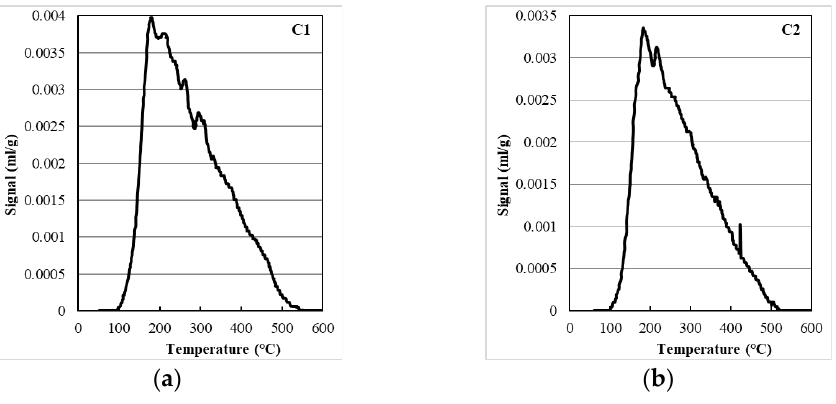
Figure 6. ( a ) Temperature-programmable desorption profiles of aluminum oxides C1. ( b ) Temperature-programmable desorption profiles of aluminum oxides C2. Table 2. The number of acid centers of aluminum oxides and catalysts based on the results of temperature-programmed ammonia desorption.